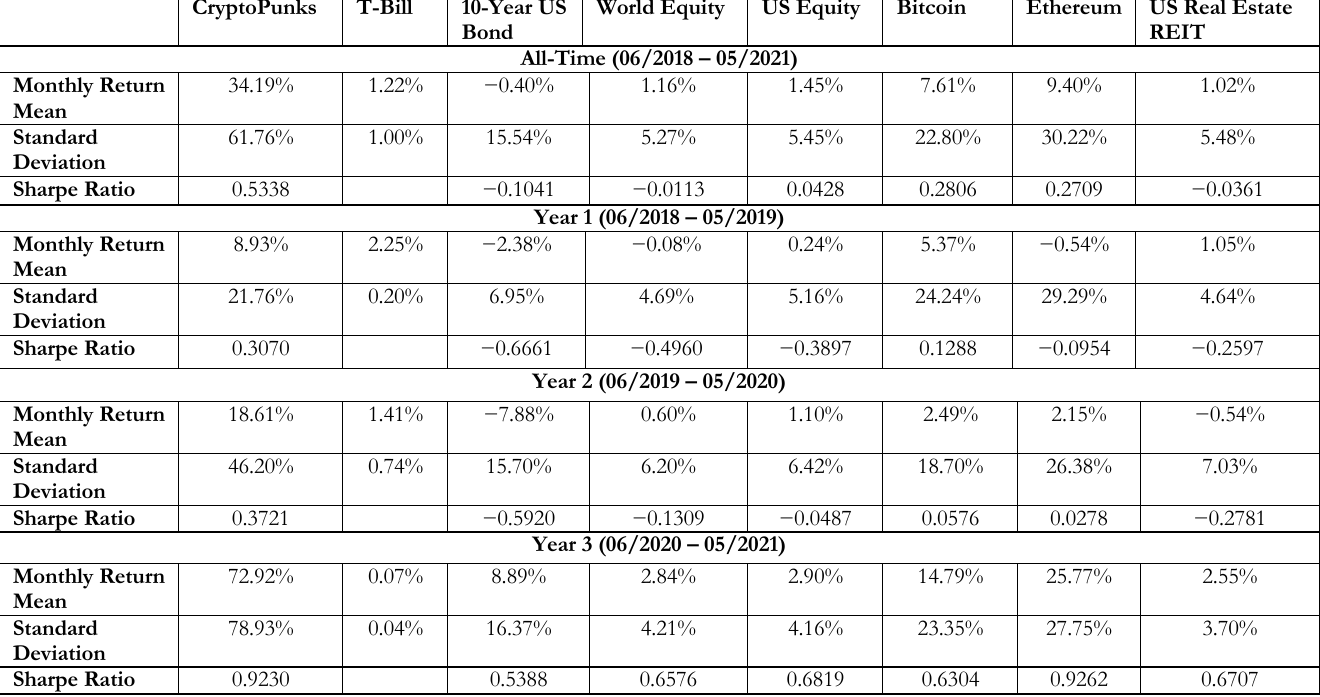
Table 8: Comparison of Investment Performance